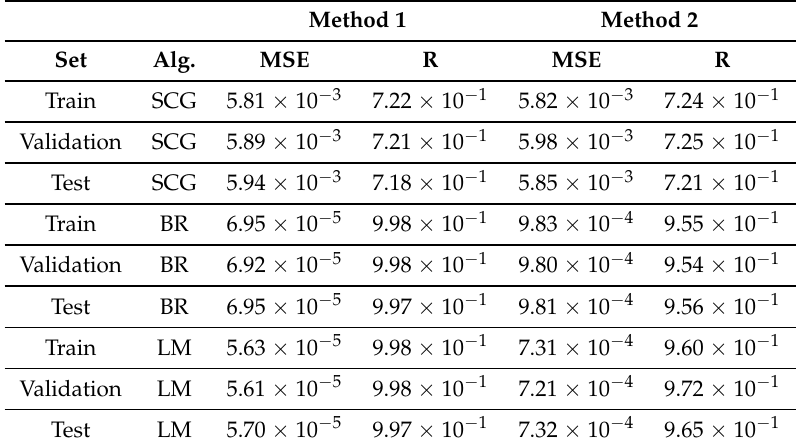
Table 4. MSE and R values for neural network based gravity vector